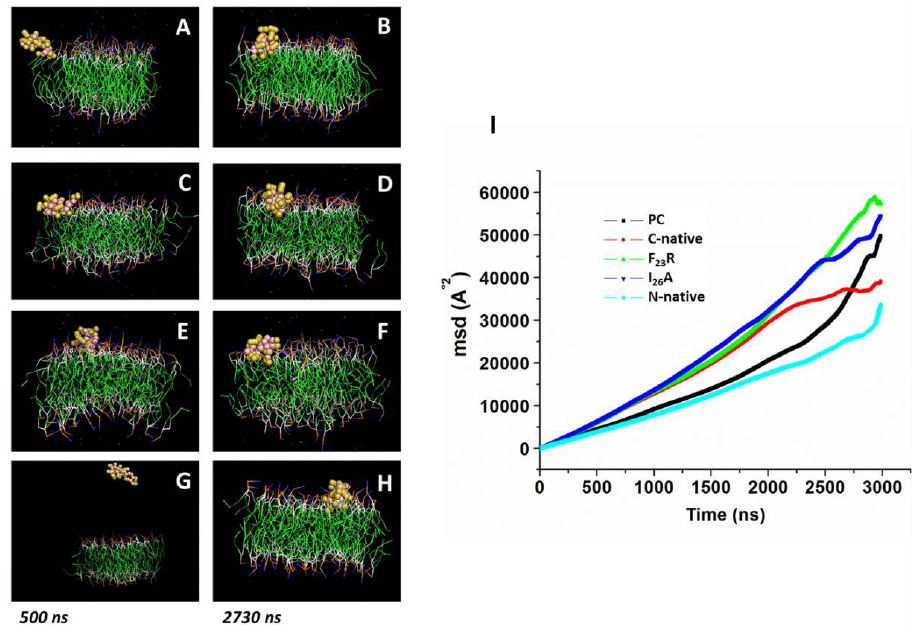
Figure 4. Displacement of peptides derived from IAPP on the z -axis of PC-bilayers (mean square deviation, MSD). Representative snapshots of PC bilayers associated with the C-native fragment of IAPP at 500 ns ( A ) and 2730 ns ( B ), F 23 R ( C , D ), I 26 A ( E , F ), and the N-native fragment ( G , H ). ( I ) Behavior of mean square deviation (Å 2 ) through a 3000 ns simulation employing coarse grain